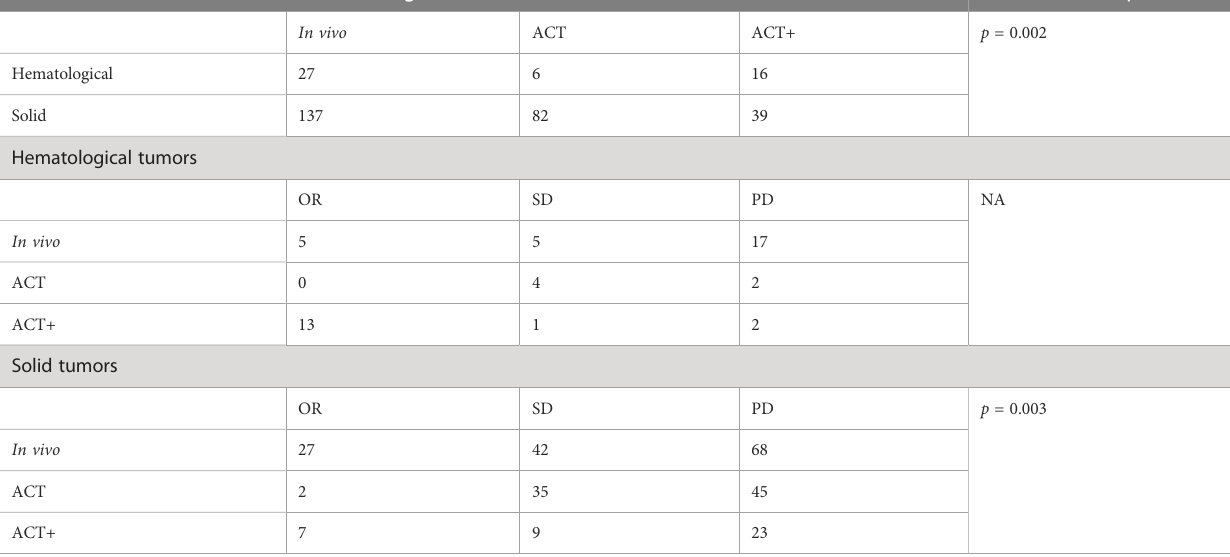
TABLE 3 Treatment strategy in fl uences in gd T cell immunotherapy ( n = 307). Treatment differences between hematological and solid tumors Pearson ’ s chi-squared test